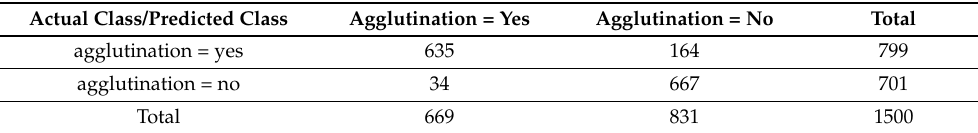
Table 9. Confusion matrix for the SURF algorithm over the 1500 patches.